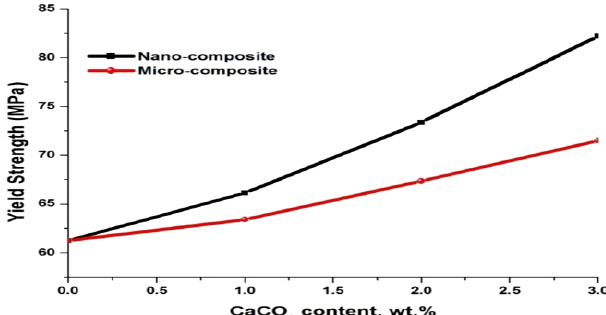
Fig. 7. Variation of tensile strength of micro- and nano-composites with filler loading at yield.